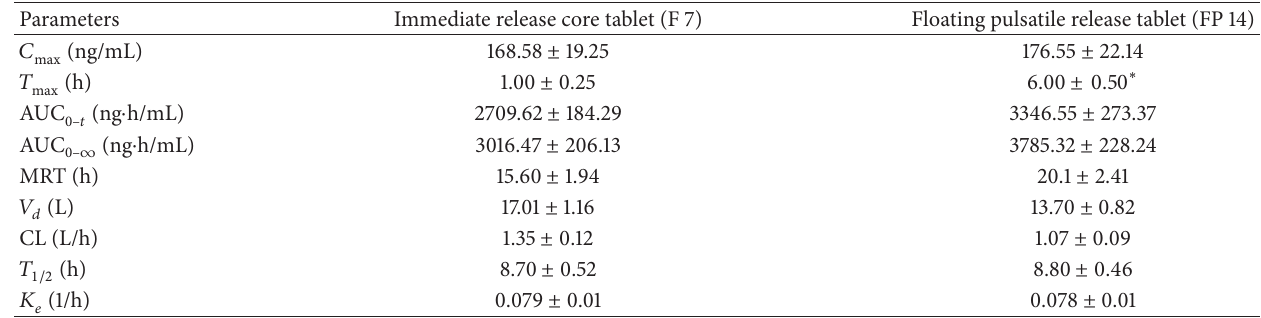
Table 7: Pharmacokinetic parameters from the plasma concentration-time